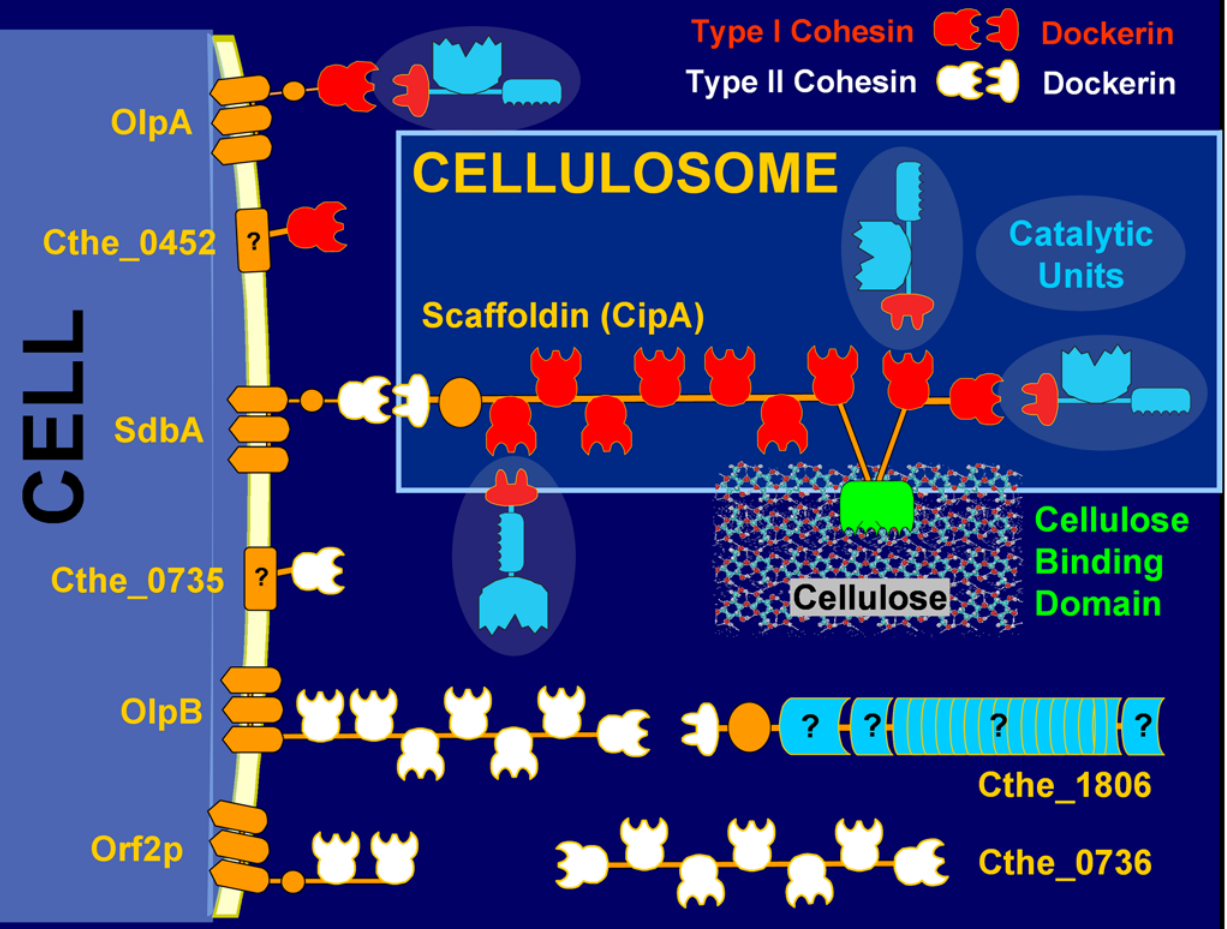
Figure 1. Simplified schematic representation of Clostridiumthermocellum cellulosomal architecture. CipA is the backbone scaffoldin protein containing 9-Type I cohesins and can accommodate up to 9-Type I dockerin bearing catalytic units. CipA also contains a Type II dockerin for cell-surface attachment via anchor proteins and a Cellulose Binding Domain for attachment to the growth substrate. C. thermocellum genome encodes five proteins with Type II cohesins, four with S-layer homology domain (SdbA, OlpB, Orf2p and Cthe0735) for cell-surface anchoring of Type II dockerin bearing CipA and one without the SLH domain (Cthe0736). Also shown is the only subunit containing a Type II dockerin (Cthe1806) – (Figure adapted with permission from Carlos Fontes, CIISA, Portugal).